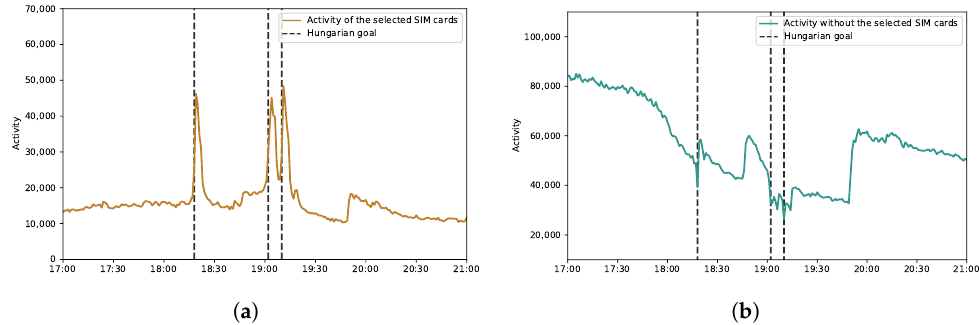
Figure 14. Mobile phone network activity of the SIM cards (fans) who showed activity right after any two of the Hungarian goals ( a ) and the activity of the other SIM cards, without the fans ( b ).